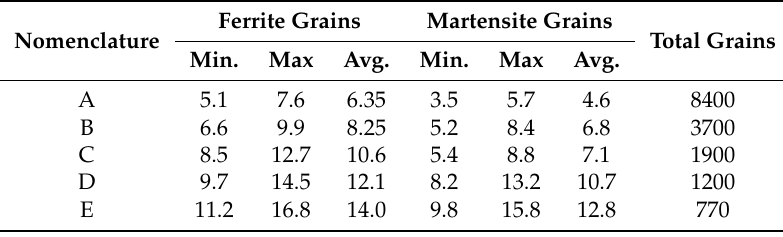
Table 1. Grain size distribution data for ferrite and martensite used for the construction of Representative Volume Elements (RVEs). The grain sizes are in µ m and “Total Grains” is a dimensionless entity.